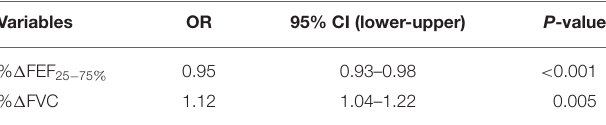
TABLE 3 | Logistic regression analysis of predictors of “restricted” in the whole